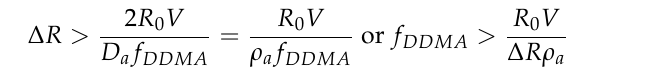
Figure 5. Echo data in the slow-time domain using the proposed method when illumination time is longer than the shifting time.